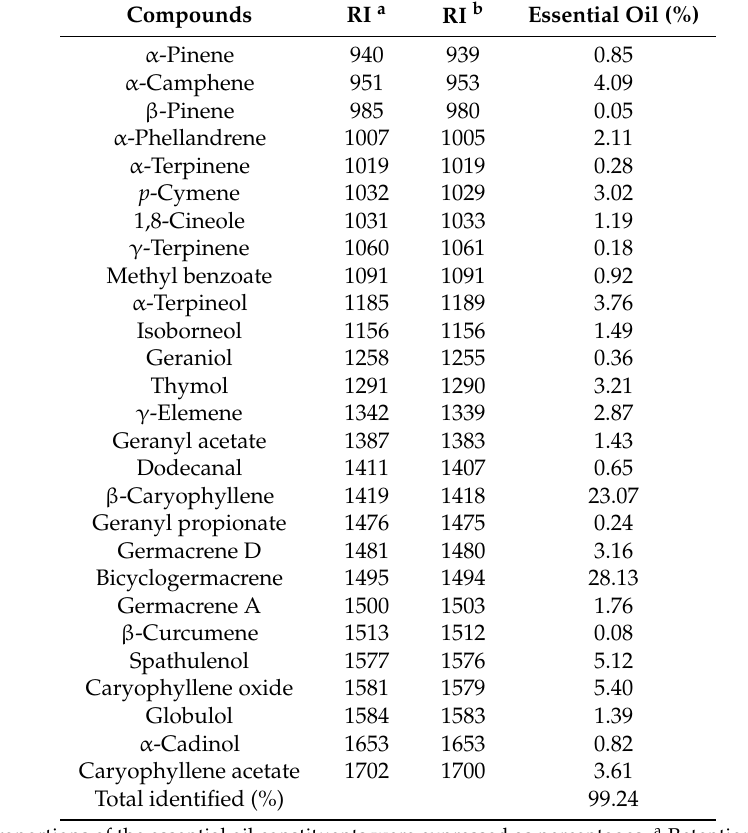
Table 1. GC-MS analysis of the composition of essential oil of R. echinus